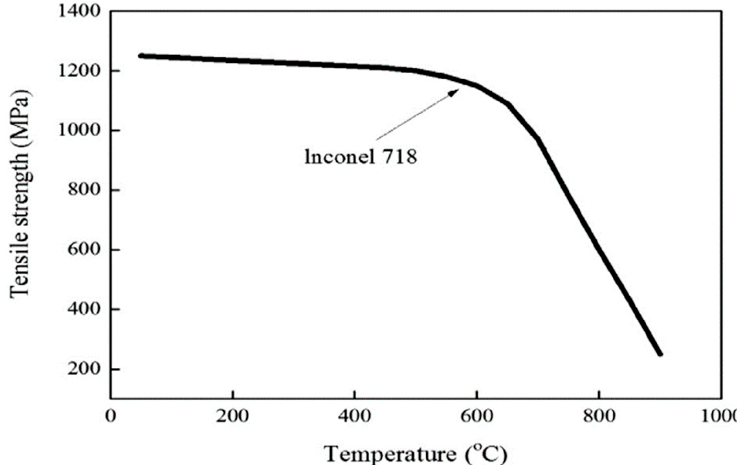
Figure 4. The tensile strength of Inconel 718 according to temperature (reproduced from [29], with permission from ELSEVIER, 2010).